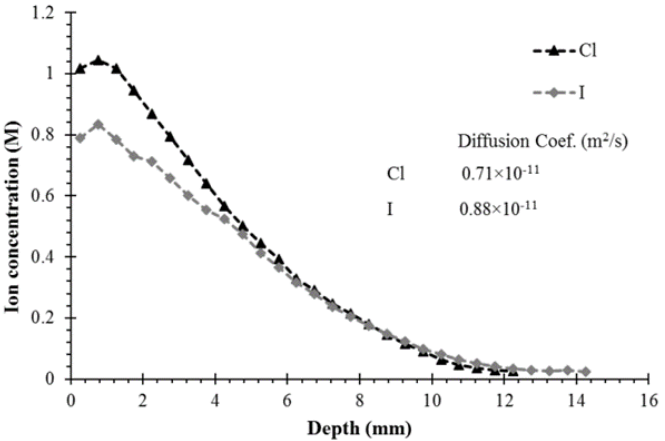
Figure A1. Comparison of iodine and chloride concentration profiles [27].